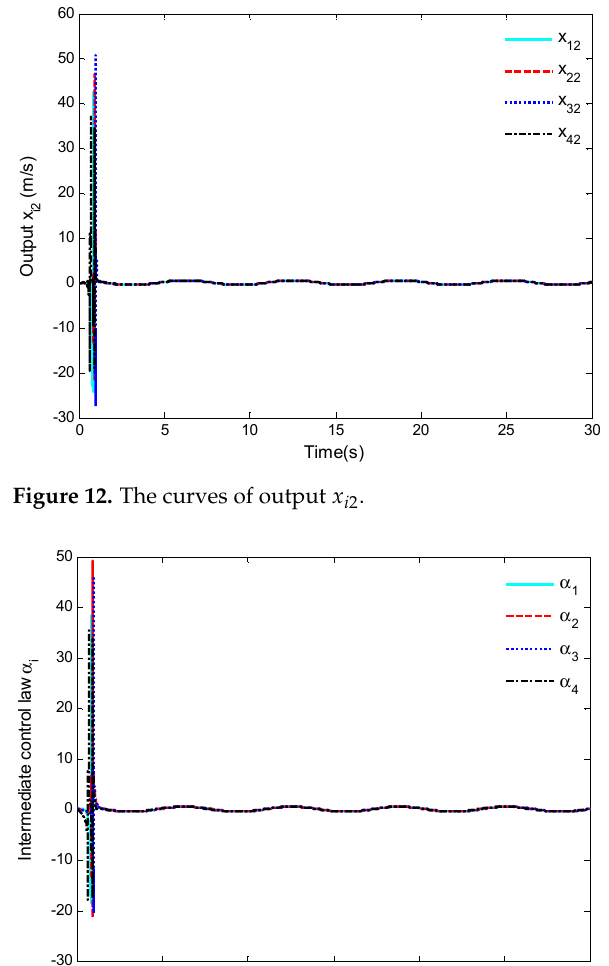
Figure 11. The curves of tracking error